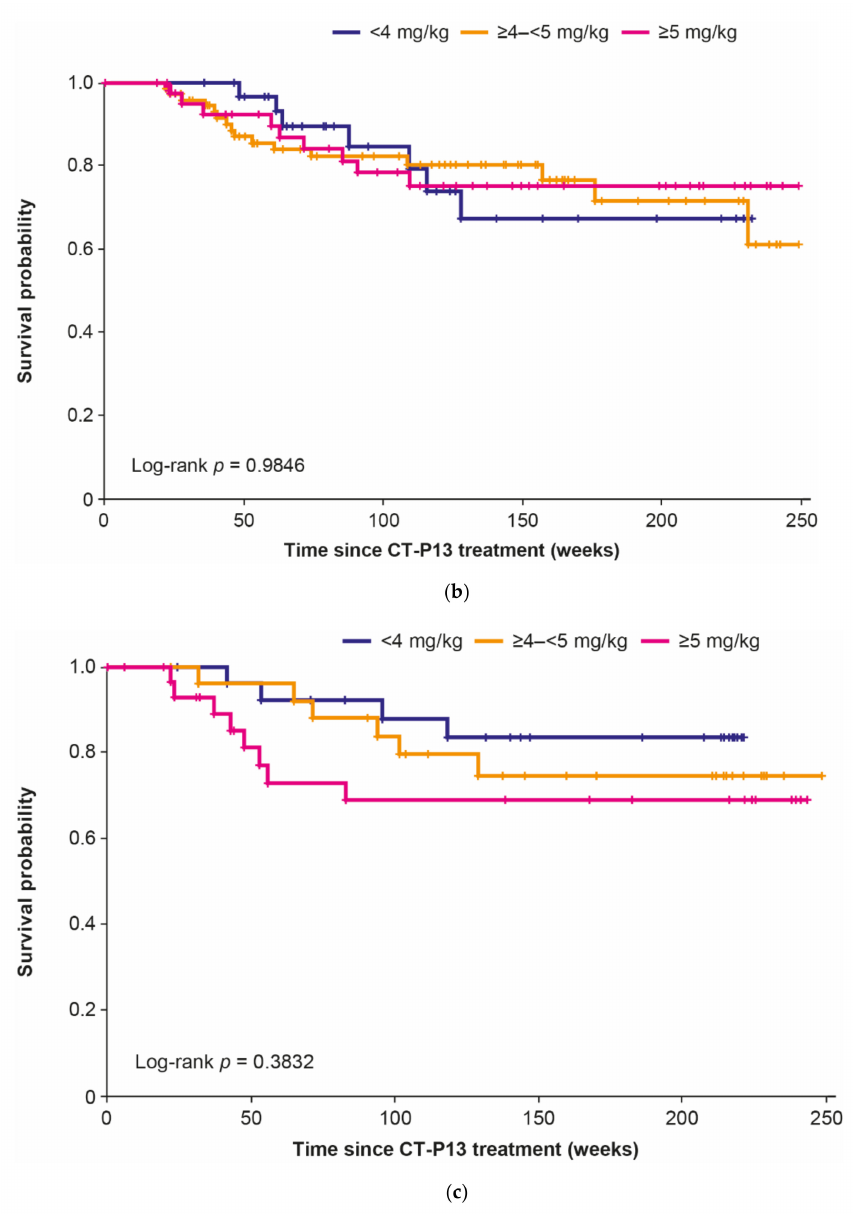
Figure 3. Drug survival by baseline dose group: ( a ) overall, ( b ) naïve patients, and ( c ) switched